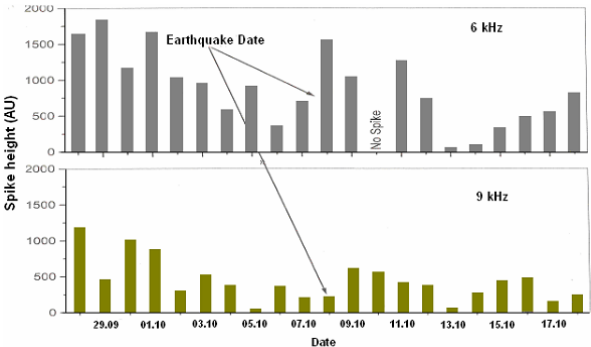
Fig. 14. Variation of spike heights above the ambient level before and after the